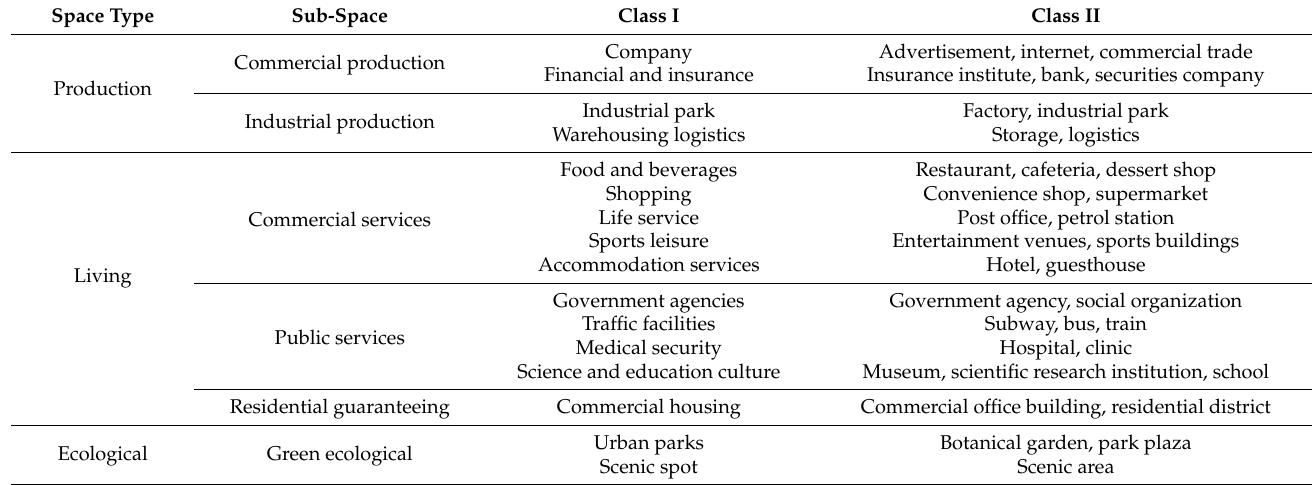
Table 1. POIs classification results based on production–living–ecological